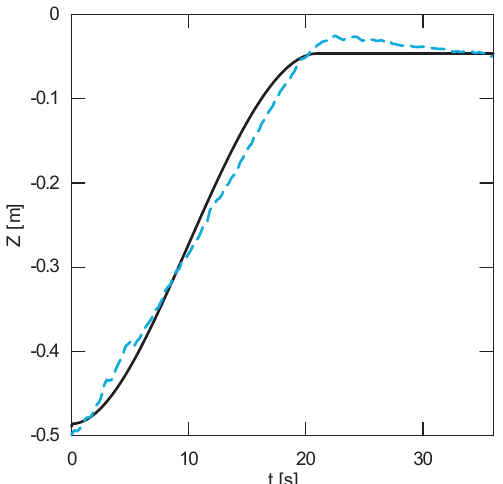
Figure 14. Change of the Z coordinate as a function of time (solid line—numerical calculations, dashed line—experiment